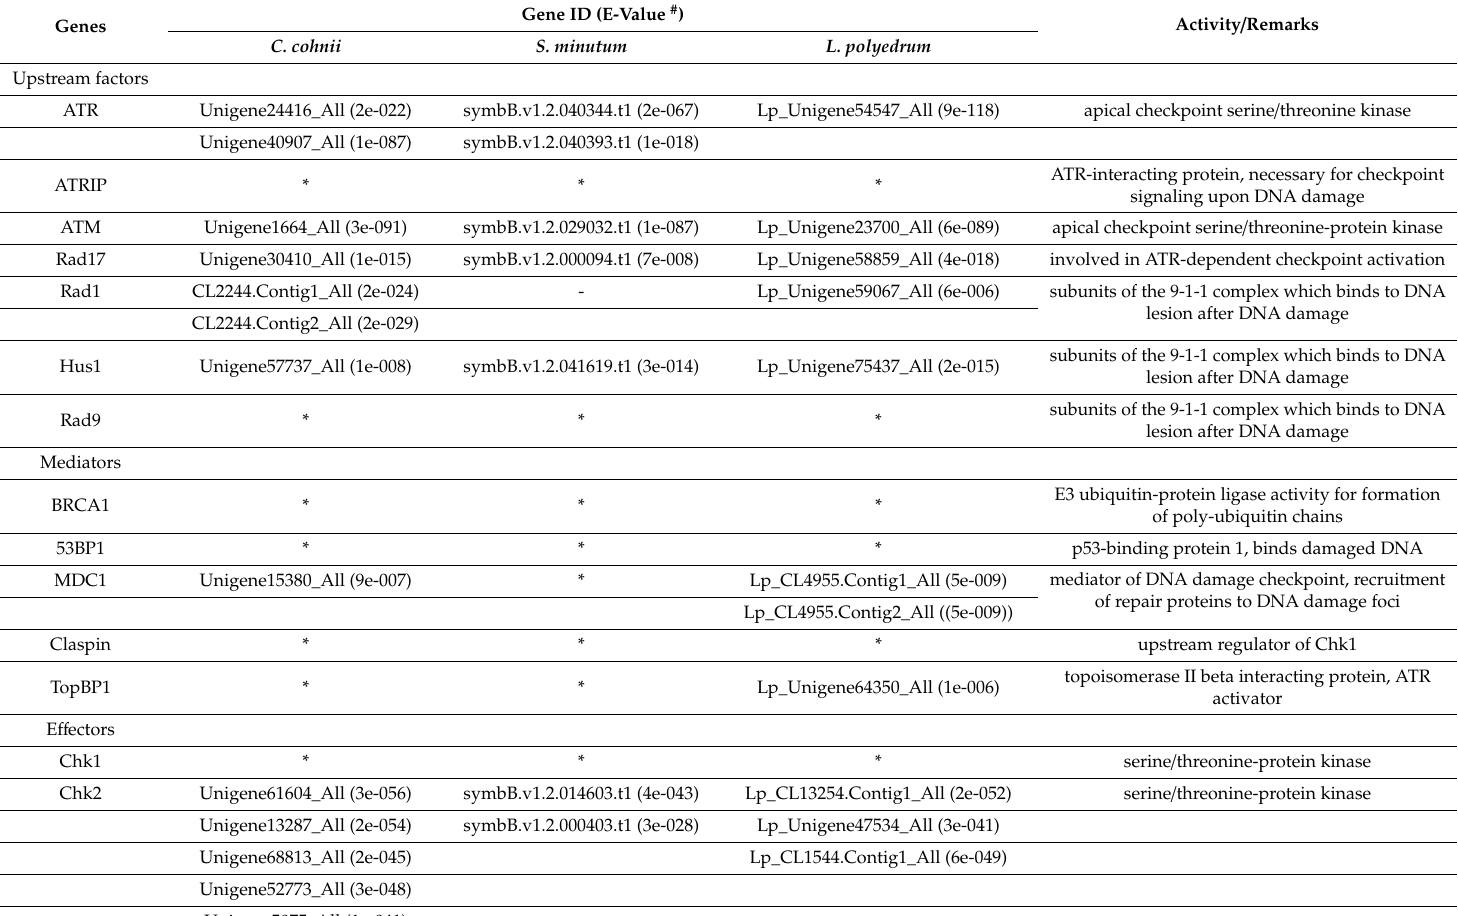
Table 1. Predicted checkpoint control genes in